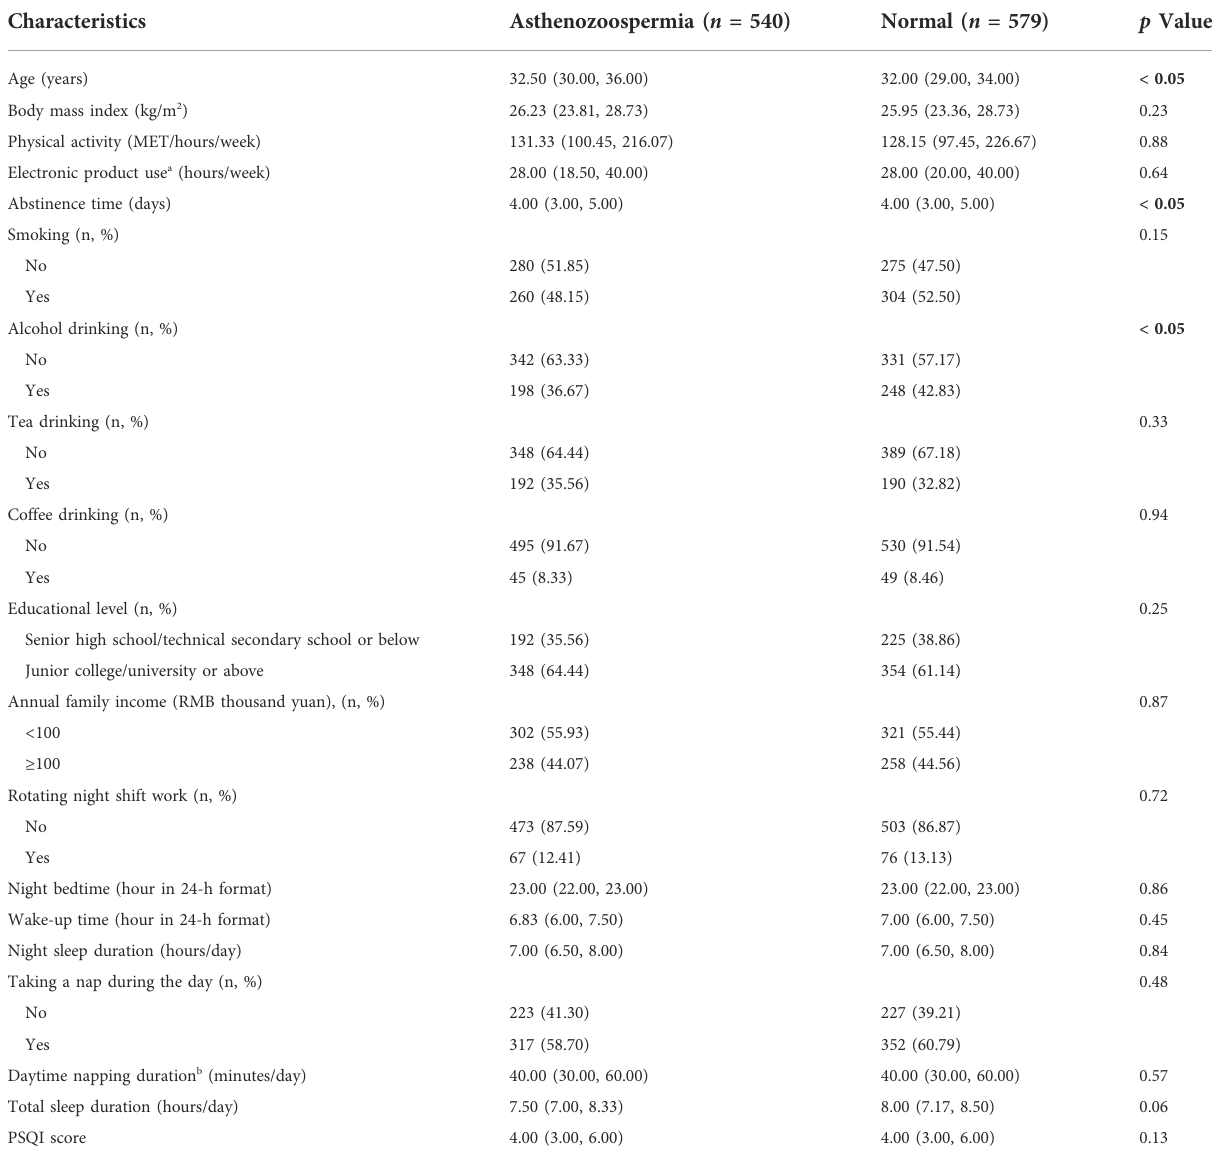
TABLE 1 Basic characteristics of